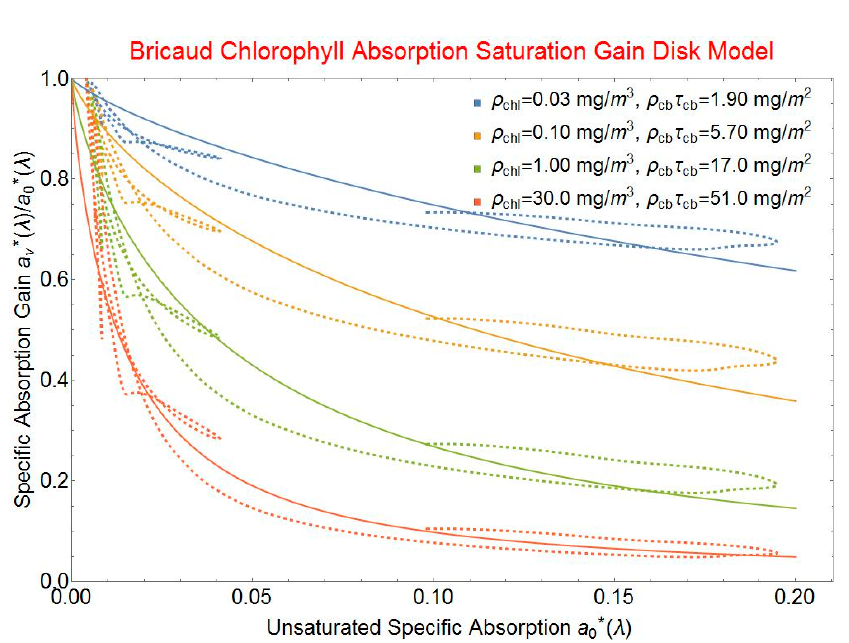
Figure 4. Graph of the ratio of the specific absorption gain to the unsaturated absorption gain. The dotted lines are from the empirical formula of Bricaud et al. [9] for chlorophyll-a. The solid lines are from Equation (21) with the parameters